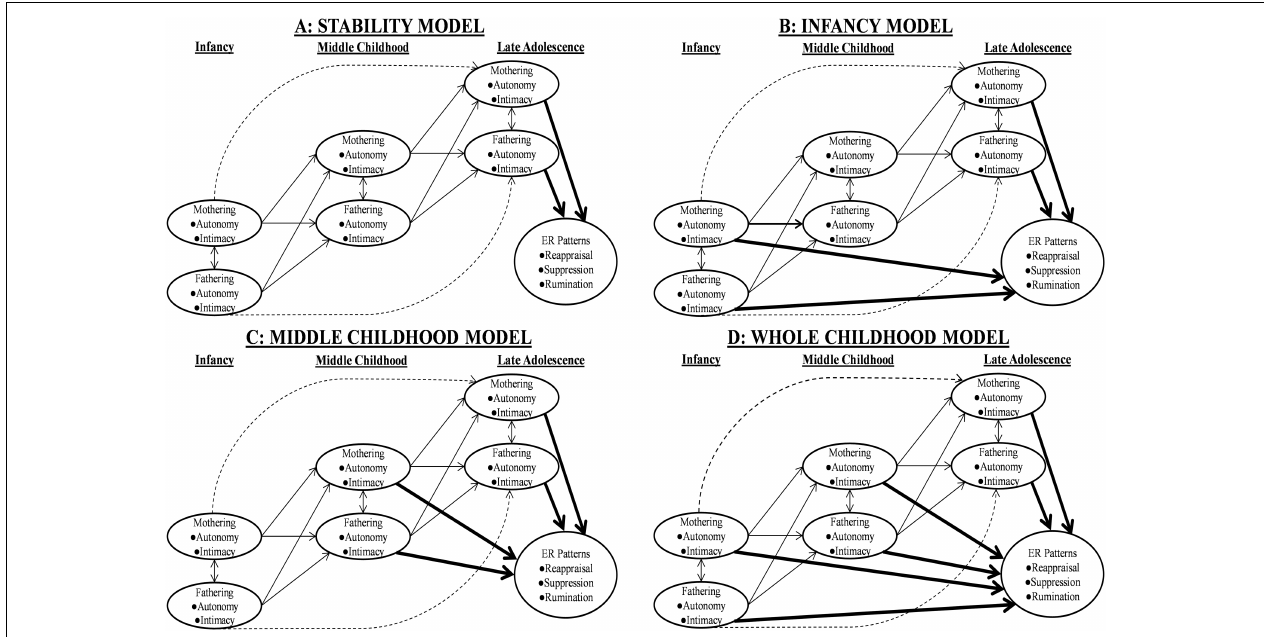
FIGURE 1 | The Hypothetical Developmental Timing Models, including the Stability Model (A) , Infancy Model (B) , Middle Childhood Model (C) , and Whole Childhood Model (D) . The bolded paths represent the paths of our main interests. The non-bolded unbroken paths represent the first-order autoregressive and cross-lagged paths and concurrent correlations of mothering and fathering. The dotted paths represent the potential second-order temporal stability paths of the mothering and fathering. ER = emotion